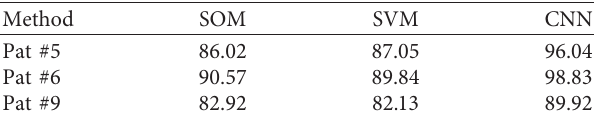
Table 4: Comparison of Gmean (%) with some state-of-the-art